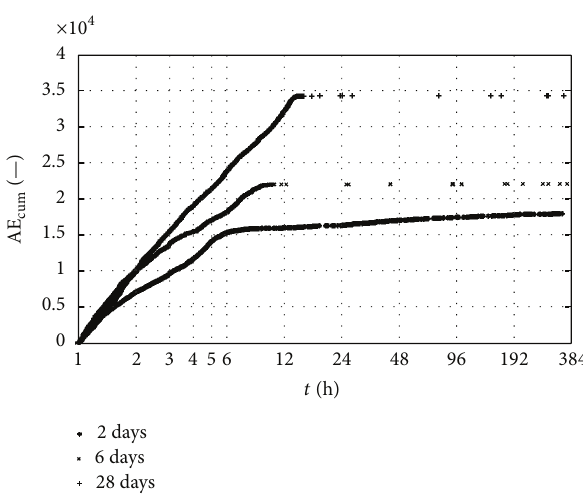
Figure 4: Cumulative acoustic emission